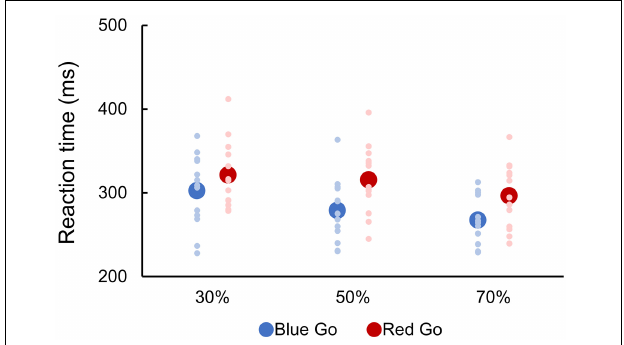
FIGURE 2 | Reaction time to go signal. There were six conditions created by crossing two target colors (Blue Go/Red No-go and Red Go/Blue No-go) and three target probabilities (30, 50, and 70%). Individual data (light color) and their mean (dark color) were presented for each condition.